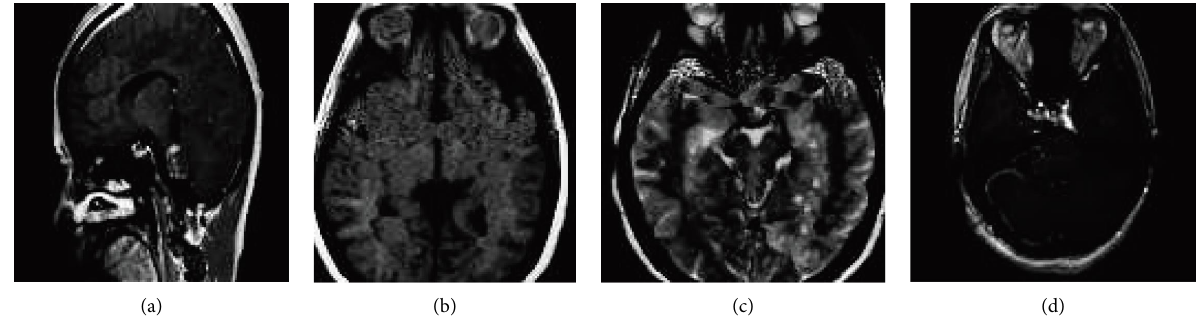
Figure 4: MRI image data of a healthy volunteer in the control group. Female, 50 years old, physical examination showed normal body function but no liver or kidney damage. (a) MRI sagittal image; (b-c) T1 weighted image; (d) T2 weighted image.